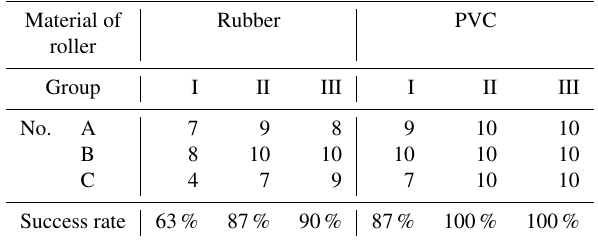
Table 3. Statistical table of experimental